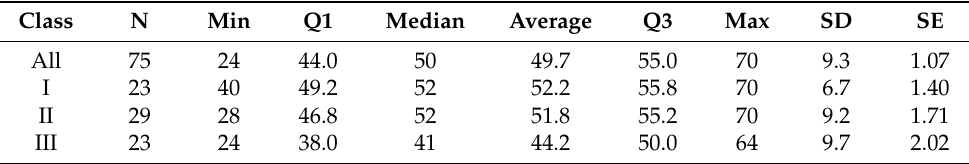
Table 1. Sagittal condylar inclination (SCI) of the left temporomandibular joint (TMJ). Table 2. Sagittal condylar inclination (SCI) of the right TMJ.